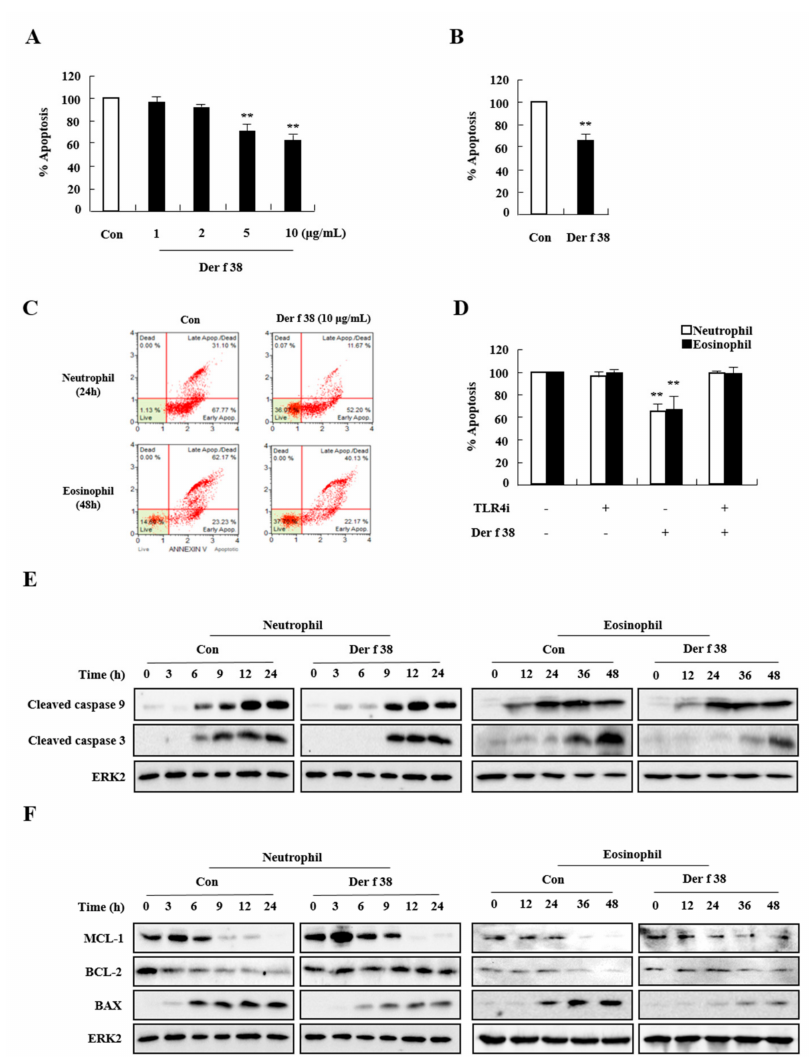
Figure 6. Der f 38 suppresses constitutive apoptosis of neutrophils and eosinophils. ( A-C ) Allergic neutrophils ( n = 8) ( A )